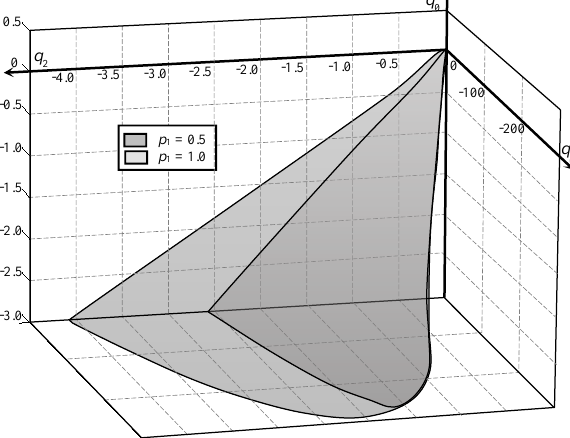
Figure 8. Stabilizing subspaces for ( q 0 q 1 q 2 ) in dependence of parameter p 1 . All these cases are not considered in the existing MOO algorithms. Thus, algorithms with variable, conditioned, and discontinuous search ranges are needed, but they are currently